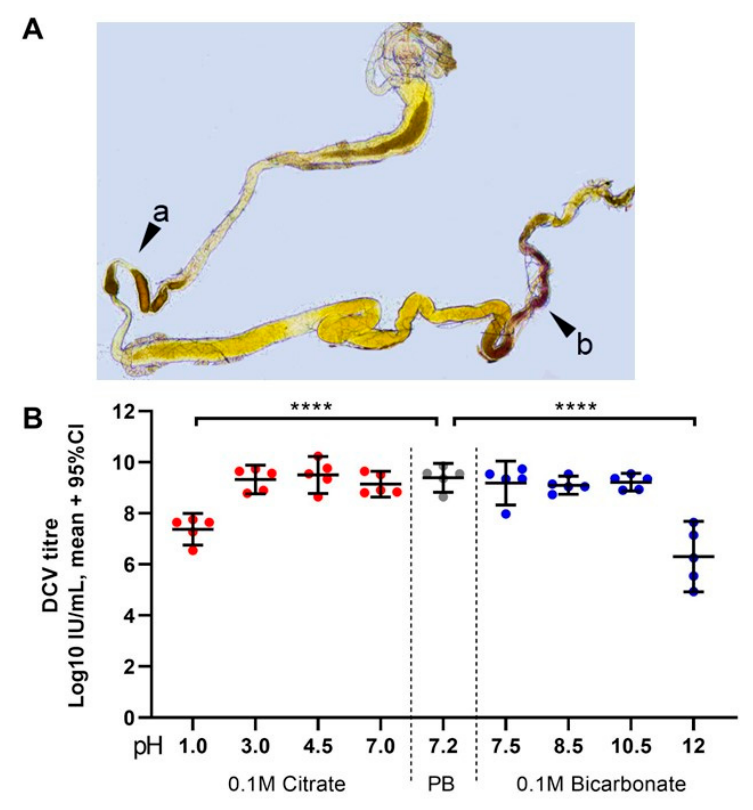
Figure 5. Highly acidic and highly alkaline conditions found in the midgut can affect DCV infectivity: ( A ) upon dissection of L1, L2, and L3 larvae, the m -cresol purple ingested shifts to a red/orange hue in the middle midgut indicating a pH between 1.2 and 2.5 (pointer a ), and to a brown/purple hue towards the end of the posterior midgut, close to the Malpighian tubules, indicating a pH > 9.0 (pointer b ). These colours fade towards yellow rapidly after dissection, as the gut is neutralised when exposed to the glycerol-PBS. Hence, colours depicted do not accurately reflect those observed in vivo or during dissection; saturation was increased for illustrative purposes. In contrast, the guts of L0 did not display the red or purple colouration of m -cresol purple at acid (pH < 2.8) or alkaline (pH > 8.5) conditions, respectively, either before or after dissection (data not shown [48]). ( B ) Aliquots of purified DCV (stock at 2.5 × 10 9 = 10 9.4 IU/mL) were incubated under acidic-to-neutral (citrate; left red circles), neutral (PB control; centre grey circles), or neutral-to-alkaline (bicarbonate; right blue circles) buffers for 15 min at room temperature and used to infect Drosophila S2 cells. DCV titre was calculated by TCID 50 , and normalised using log-transformation. Each condition was compared to the PB-treated control (in which the purified DCV aliquots were maintained) using Šídák’s multiple comparisons test. Compared to the PB pH 7.2 treatment, highly acidic conditions (Citrate, pH 1.0) decreased the viral titre by 2 orders of magnitude (mean, 10 7.37 vs. 10 9.39 IU/mL), whereas highly alkaline conditions (bicarbonate, pH = 12.0) decreased the viral titre by 3 orders of magnitude (mean, 10 6.30 vs. 10 9.39 IU/mL) ( p < 0.0001 for both comparisons). Acidic conditions found within the middle midgut (pH 1–2) may significantly decrease the DCV infectivity, whereas alkaline conditions similar to those found in the posterior midgut (pH 7.5–10.5) are likely not to affect the stability or the remaining infectious